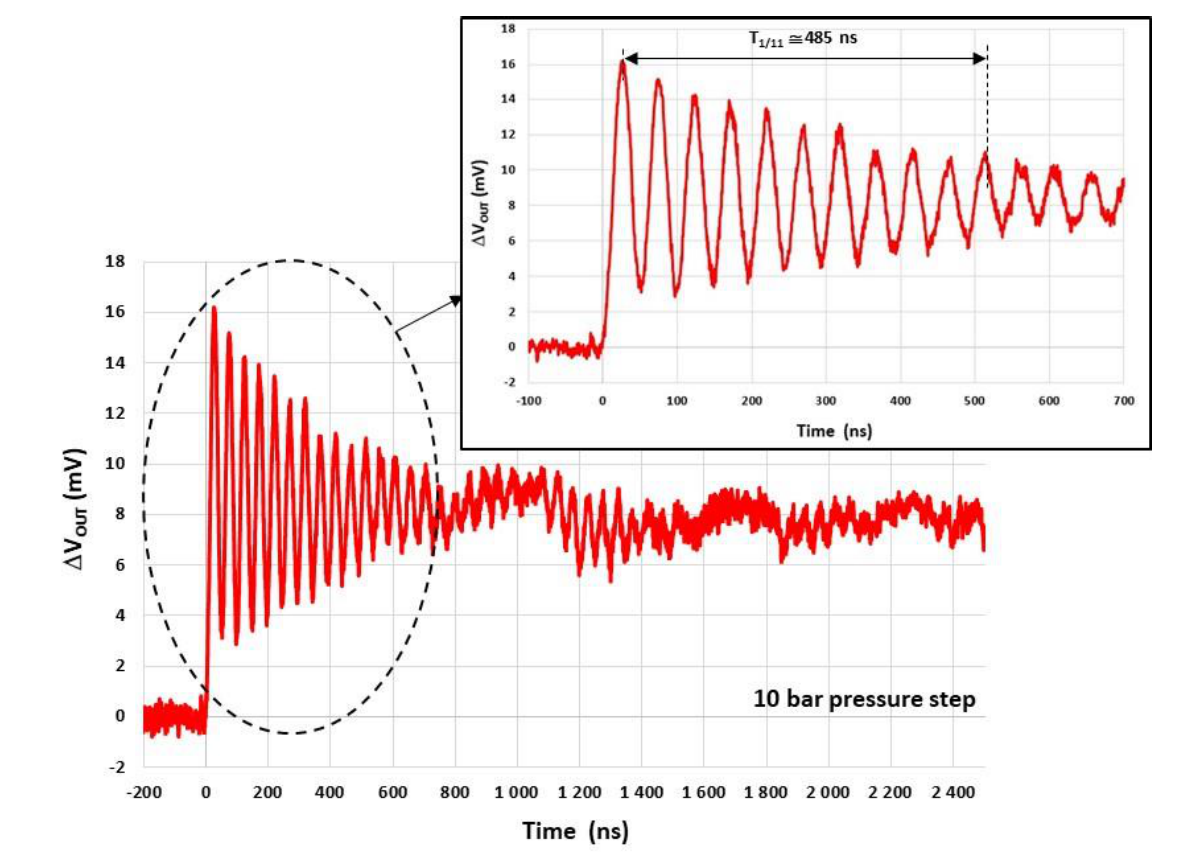
Figure 26. Measured system response ∆𝑉 𝑂𝑈𝑇 to a pressure step of 10 bars.